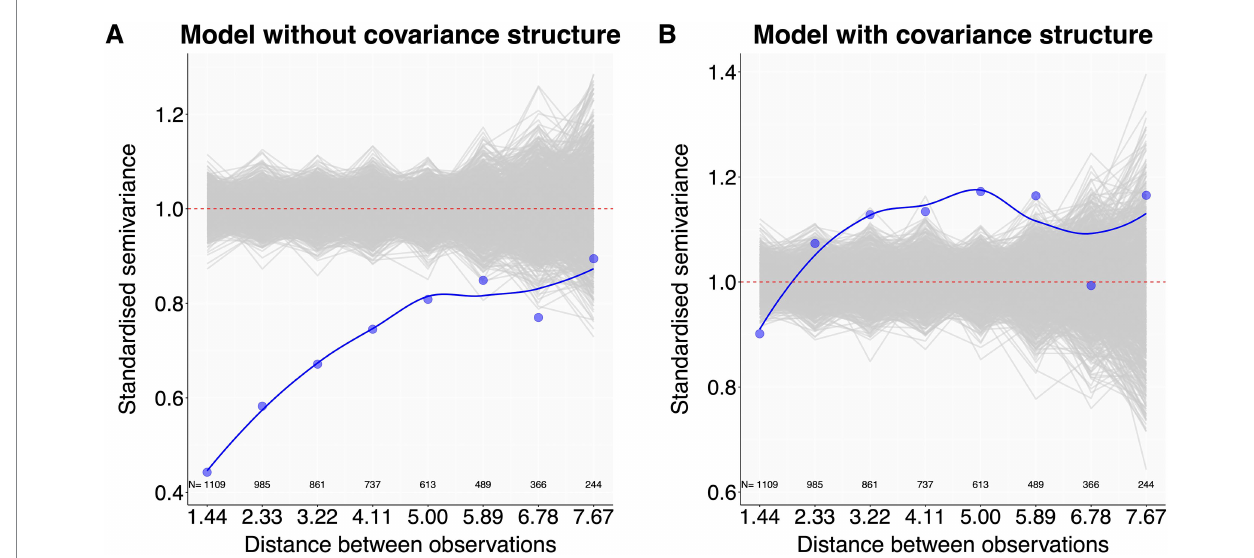
FIGURE 4 Autocorrelation checks - examples. Plot (A) shows that observations with a pairwise distance up to 6 have more similar residuals (blue dots and blue line) than expected at random (gray lines), indicating spatial autocorrelation. Plot (B) , now almost free of autocorrelation, was produced by informing the model with the autocorrelation structure of the observations. N values are the number of observation pairs in the dataset within each distance step indicated on the x-axis. Dataset reworked from Santon et al.